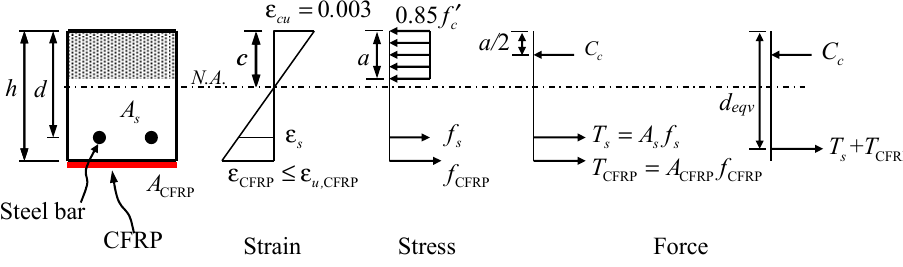
Figure 8. Strain, stress and force distributions in the section at ultimate strength.